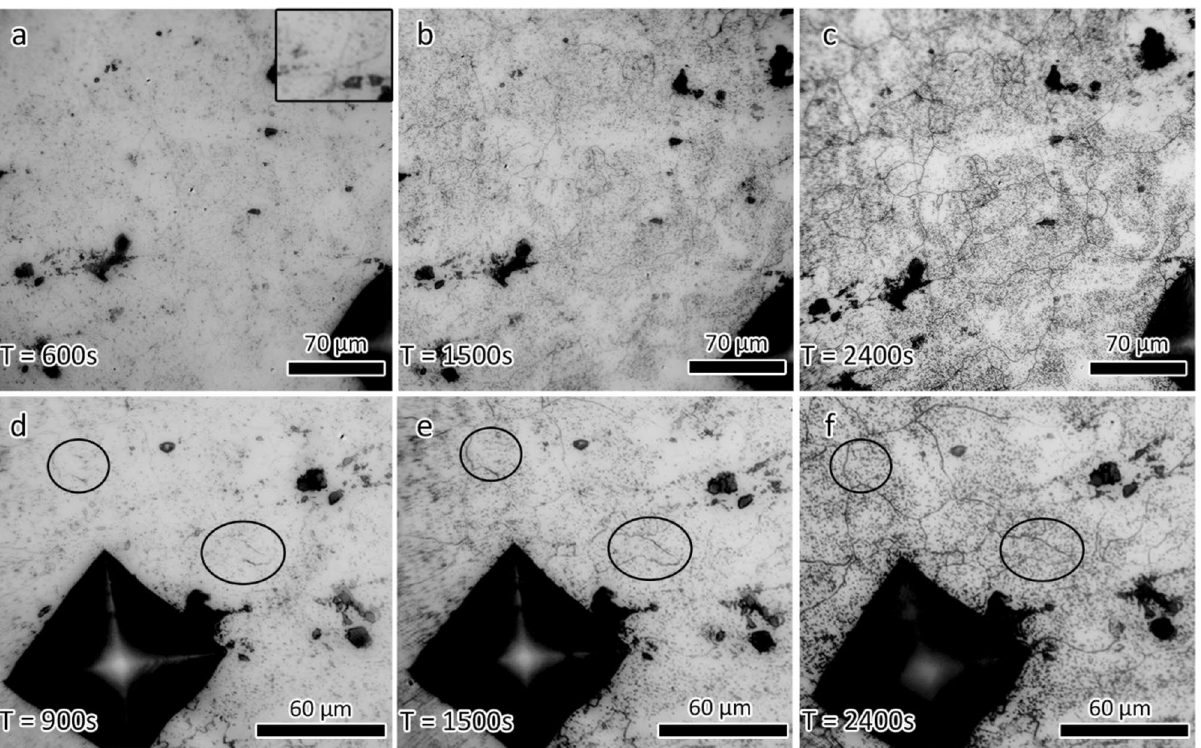
Figure 2. ( a )–( c ) Optical images taken during the in situ optical microscopy corrosion experiment. Inset in ( a ) highlights a grain boundary attacked at the earliest stage of corrosion. ( d )–( f ) Different region on the same sample. Circles highlight corrosion progression of partially corroded GBs to fully corroded GBs. Experiment time is given in each